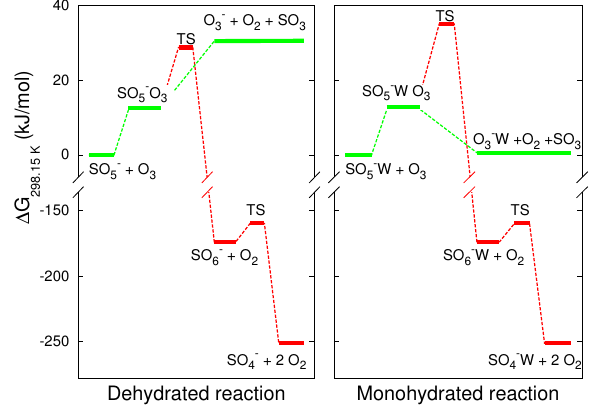
Fig. 3. Schematic overview of the Gibbs free energy of the relevant species at standard conditions. The barrier height for O 2 SO − 3 idation is increased by ca. 6kJmol − 1 by the presence of a water molecule while the thermodynamics of charge transfer and clus- ter decomposition is changed from distinctly endothermic to almost thermoneutral. At standard conditions and 50% relative humidity, ca. 90% of O 2 SO − 3 is monohydrated.